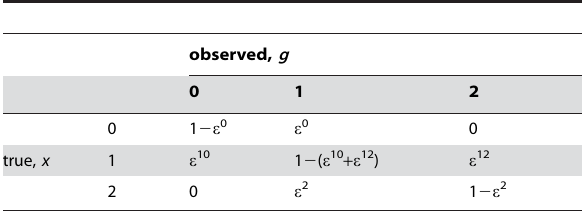
Table 1. Error model represented as a transition probability